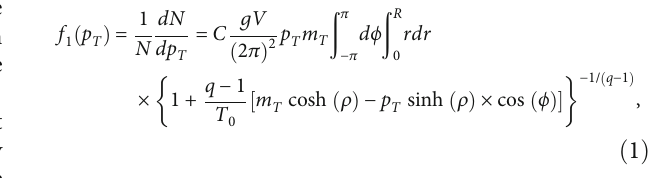
β ), entropy index ( q ), normalization constant ( N 0 ), χ 2 , and degree of freedom (dof) 0 and T